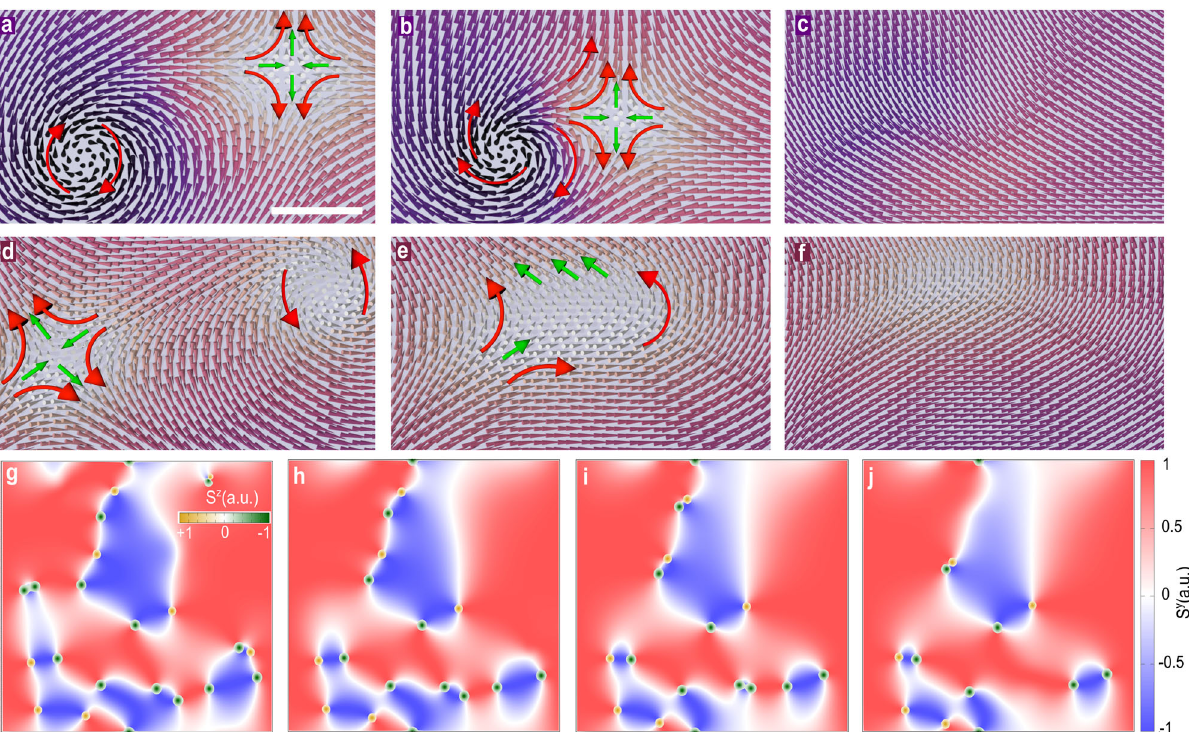
Fig. 3 Meron and antimeron collision. a – c , d – f Snapshots of the vortex and antivortex dynamics with antiparallel and parallel core polarization, respectively, before ( a , d ), during ( b , e ), and after ( c , f ) the collisions at zero fi eld and 0 K. The dark and bright backgrounds indicate a more out-of-plane magnetization at the core of the vortex and antivortex. The big arrows in a , b , d , and e indicate the average behavior of the in-plane spin components in the perimeter. In all considered topological spin textures, similar collision scenarios are observed, which take roughly between 0.57 ns ( a – c ) and 0.17 ns ( d – f ) to occur. Scale bar is 4 nm. g – j Macroscale magnetic domains (blue and red) at different times showing the evolution of the merons and antimerons (small circles in green and orange) at the boundary between magnetic domains. The S y component (color map) of the magnetization is utilized to show the magnetic domain structure whereas S z for the vortex and antivortex textures. The white boundary near where the merons and antimerons are localized have S y = 0 and S x = 0 (Supplementary Fig. S6). S z reaches its maximum magnitude at the center of the spin textures (inset color map in g ). The dynamics of the domains is directly coupled to the motion of the merons and antimerons, and vice-versa. At suf fi cient longer times, the entire system results in a mono-domain throughout the